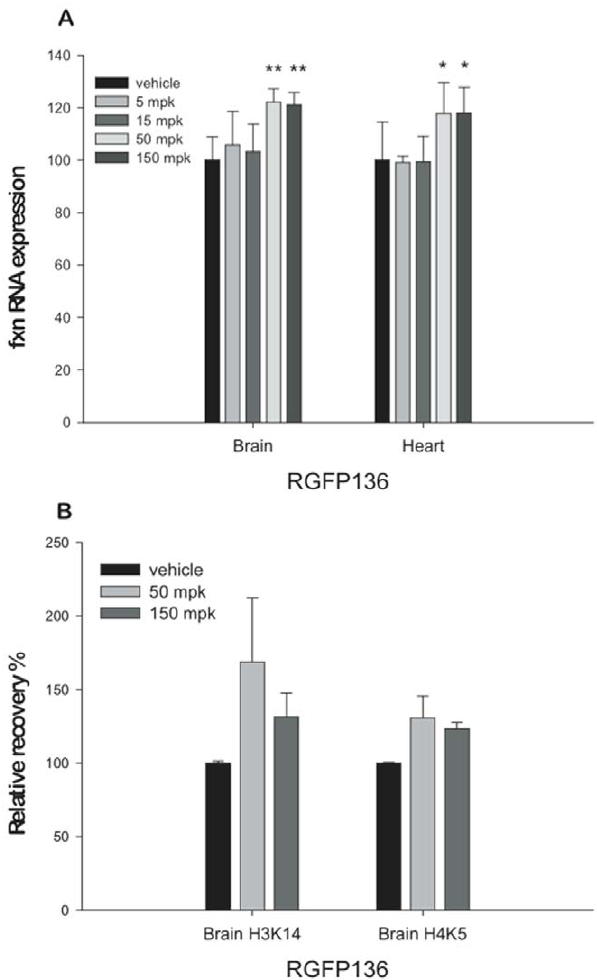
Figure 3. Frataxin expression changes as function of drug 136 dosage. A. Fxn mRNA measurement by quantitative real-time RT-PCR in brain and heart of KIKI mice dosed subcutaneously with 136 at 5 (n=7), 15 (n=7), 50 (n=6) or 150 (n=6) mg/kg or vehicle (n=13) as negative control. Fxn levels were relative to RER1 and beta-2 microglobulin ( b 2M). The Fxn level in vehicle injected KIKI of each tissue was set to 100. All quantifications were done in triplicate and bars indicate s.d. (** p , 0.001; * p , 0.05). B. Levels of H4K5 and H3K14 acetylation in KIKI mice brain treated with one subcutaneous injection of 50 or 150 mg/kg of 136 compared to vehicle-treated KIKI littermates (n=4). We performed ChIP experiments with antibodies for murine histones H3 and H4 carrying each modification. Primer pairs corre- sponded to the first intron of the mouse frataxin gene just upstream of the point of insertion of the GAA repeat in KIKI mice. Relative recovery, determined by qPCR, is expressed in relation to GAPDH and the recovery in samples from vehicle treated KIKI animals is set to 100 for each antibody. Each immunoprecipitation was quantified in triplicate, Error bars are